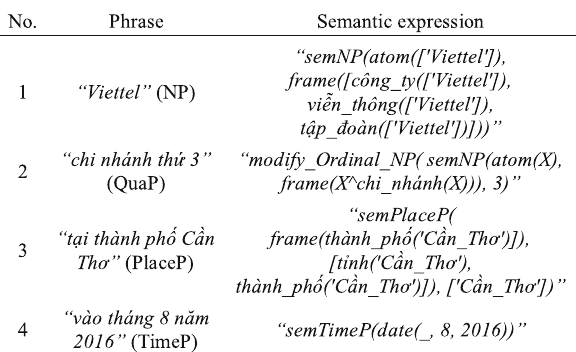
Table 15 Summary of semantic expressions of